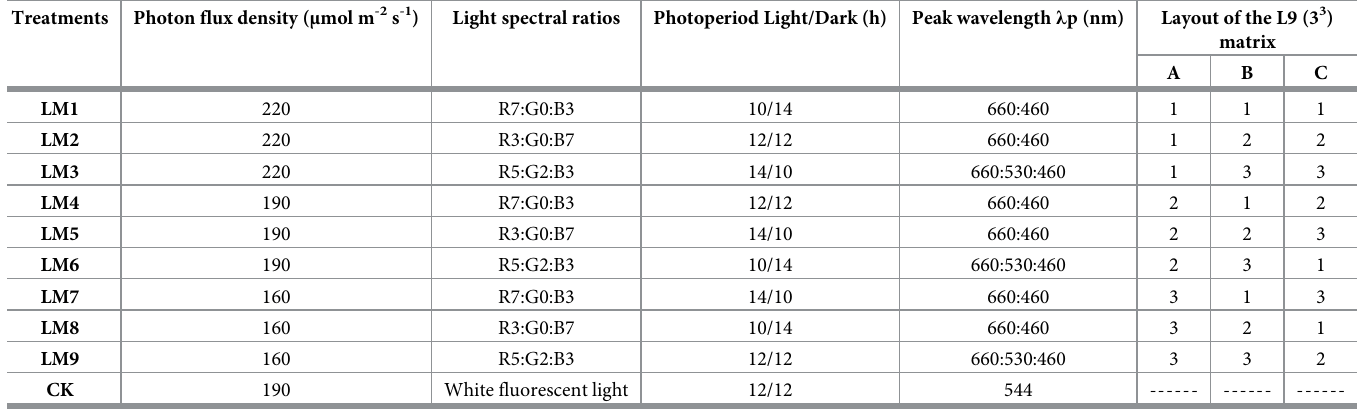
Table 1. The properties of treatments used in the study. Treatments Photon flux density ( μ mol m -2 s -1 ) Light spectral ratios Photoperiod Light/Dark (h) Peak wavelength λ p